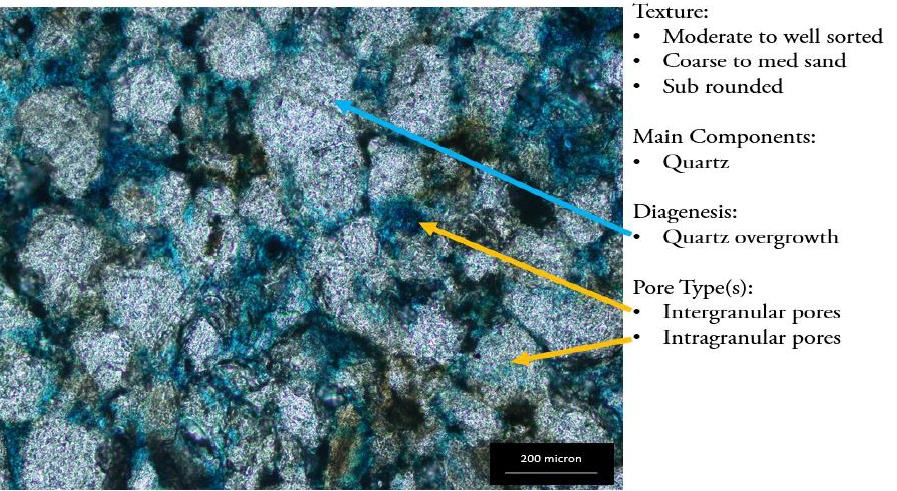
Figure 14. Textural and compositional features of L803 Belait.